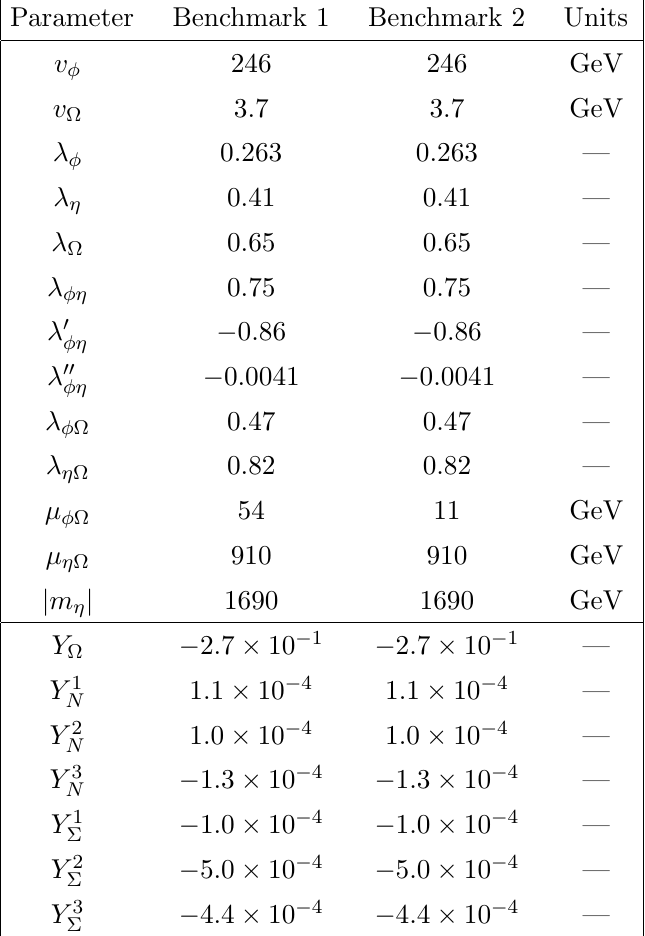
Table 2 . Independent parameters for the benchmark, relevant for the scalar sector, including dark matter (above), and the Yukawa sector